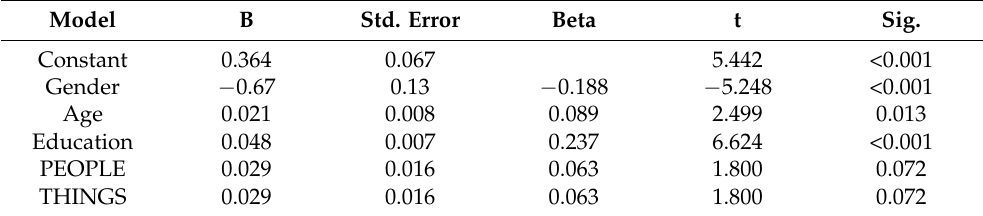
Table 4. Results from the regression